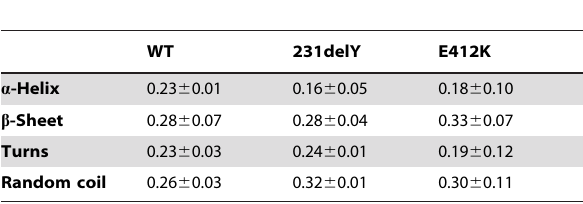
Table 3. Secondary structure composition as estimated by the CD spectra of the recombinant prolidase